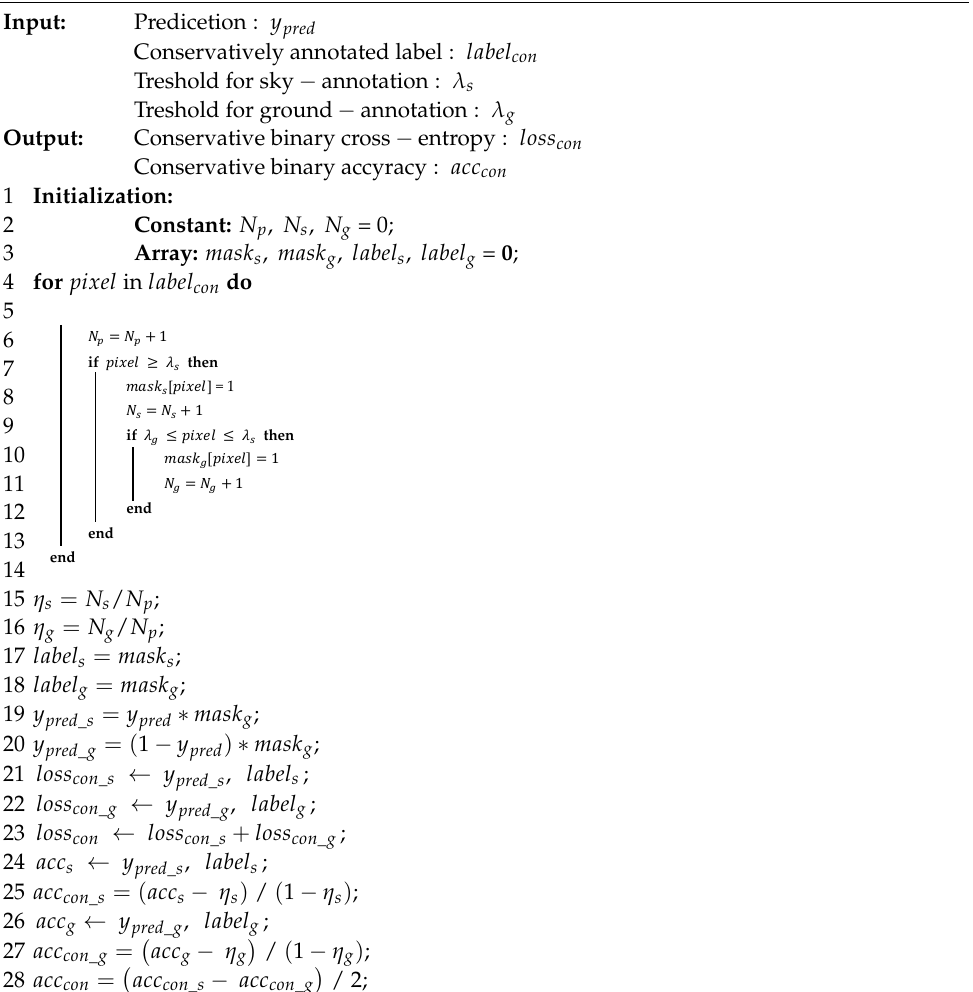
Algorithm A1 Conservative loss and accuracy in once gradient descent